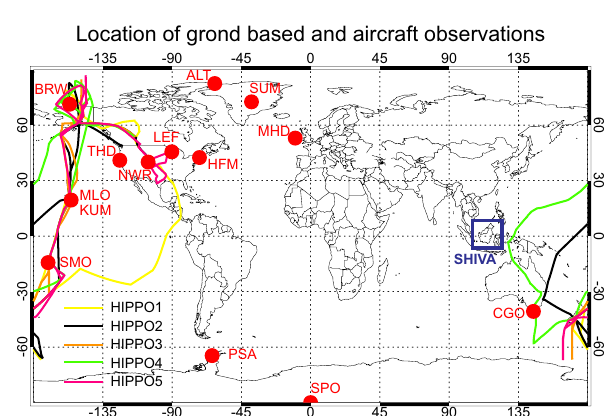
Fig. 4. Location of NOAA/ESRL ground-based monitoring stations. Note, the close proximity of stations MLO and KUM (see Table 2). In this work we group the stations into 5 latitude bands; high NH ( ≥ 60 ◦ N), midlatitude NH (30–60 ◦ N), tropical ( ± 30 ◦ ), midlati- tude SH (30–60 ◦ S) and high SH ( ≥ 60 ◦ S). Also shown are the flight tracks from the NSF HIPPO aircraft campaigns (1–5) which took place between 2009 and 2011 (see Sect. 4). The location of the SHIVA aircraft campaign (see Sect. 5) that took place in the tropical western Pacific during Nov–Dec 2011 is also